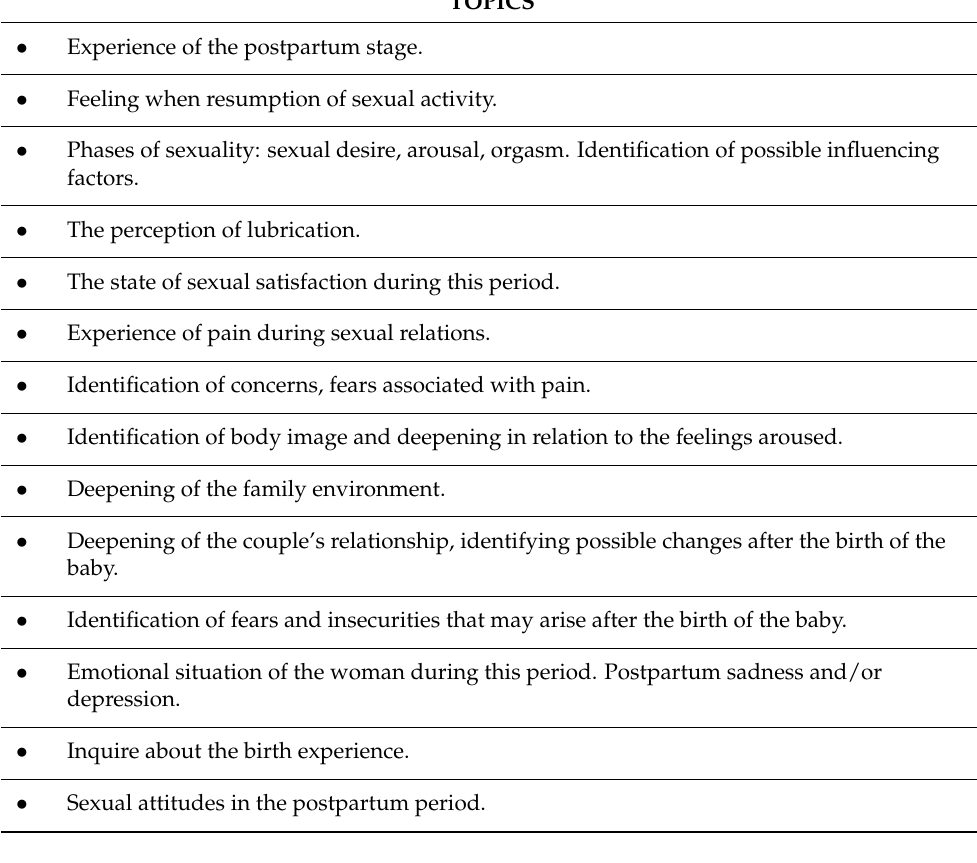
Table 1. Issues covered in the interviews, the discussion group, and the online forum.